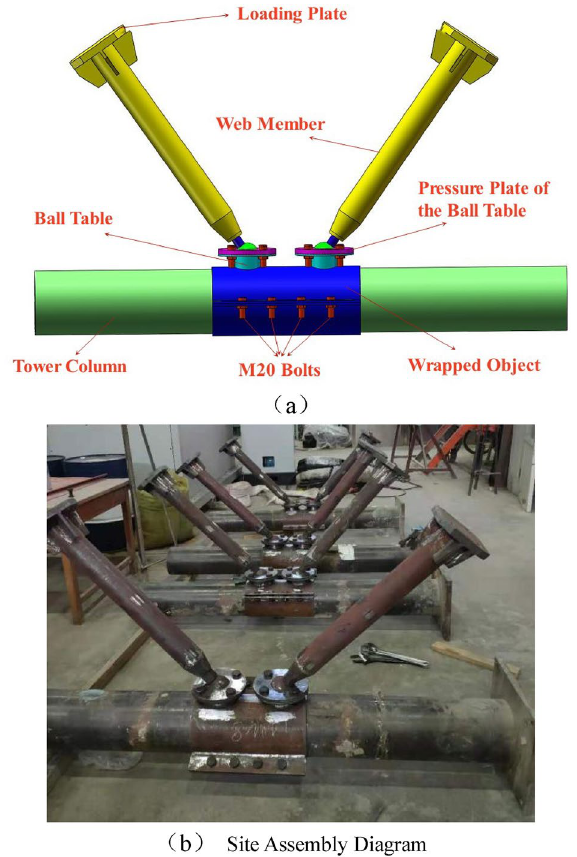
Figure 1. Specimen structure and site assembly drawing.